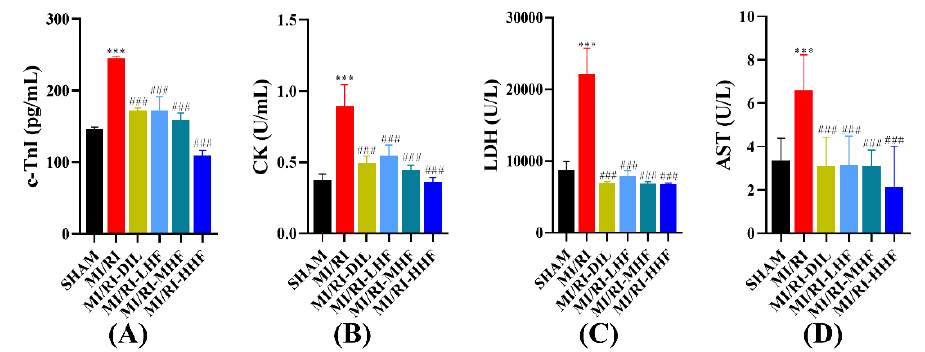
Figure 4. Effects of HF on myocardial injury markers. ( A ) c-TnI ( n = 15~16). ( B ) CK ( n = 15~16). ( C ) LDH ( n = 15~16). ( D ) AST ( n = 15~16). Results were expressed as mean ± SD. *** p < 0.001 vs. SHAM group. ### p < 0.001 vs. MI/RI group.